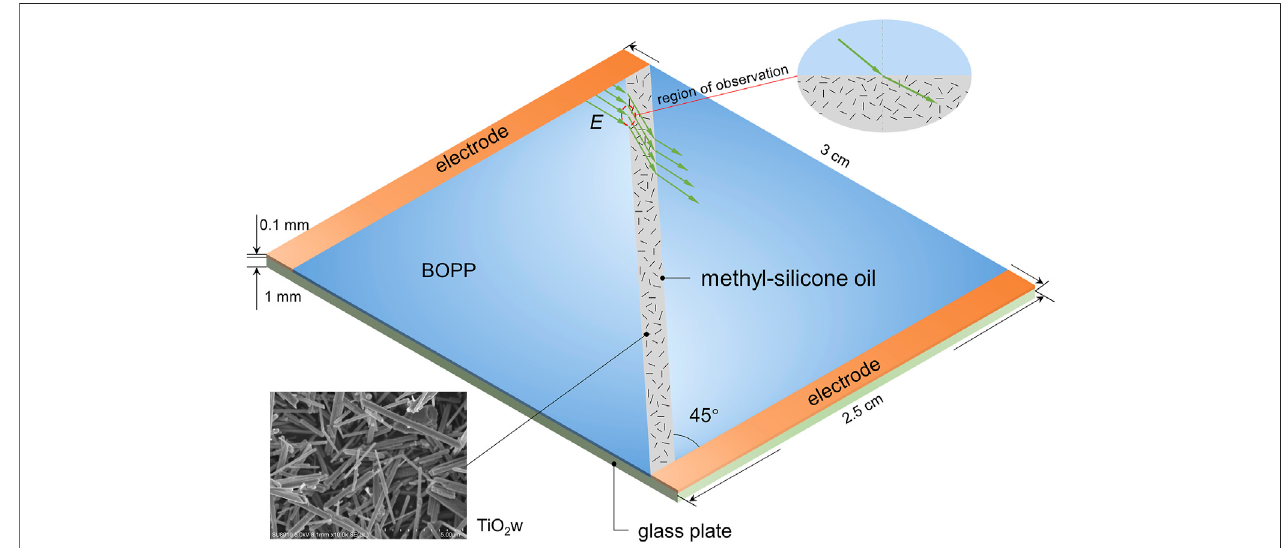
FIGURE 4 | Experimental setup for online observation of tensor